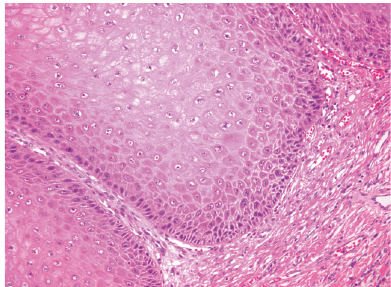
Figure 3: On microscopy, the tumor front is broad-based and pushes the subepithelial tissues [haematoxylin-eosin stain, original magnification x200].